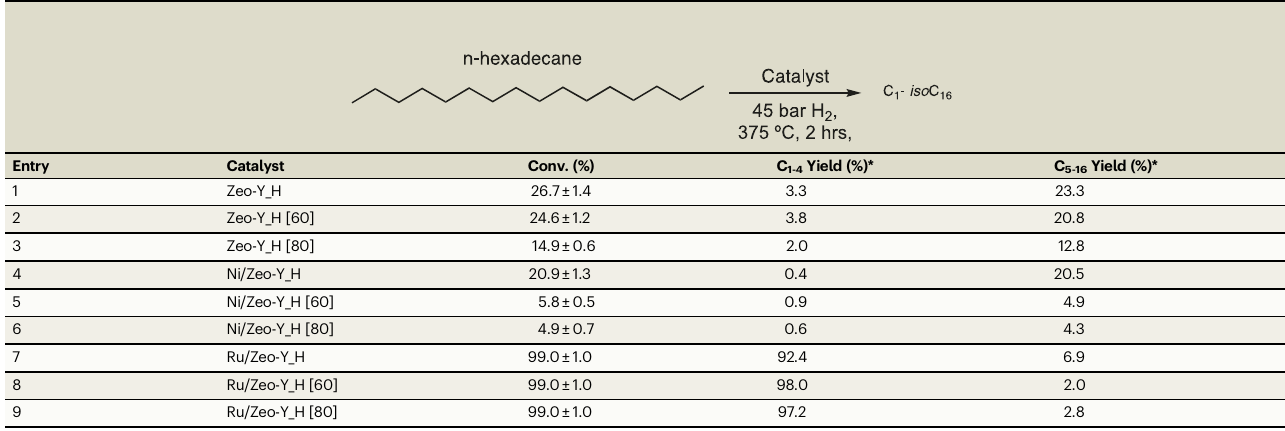
Table 4 | n- Hexadecane deconstruction with the additional Zeo-Y_H-based catalysts with varying